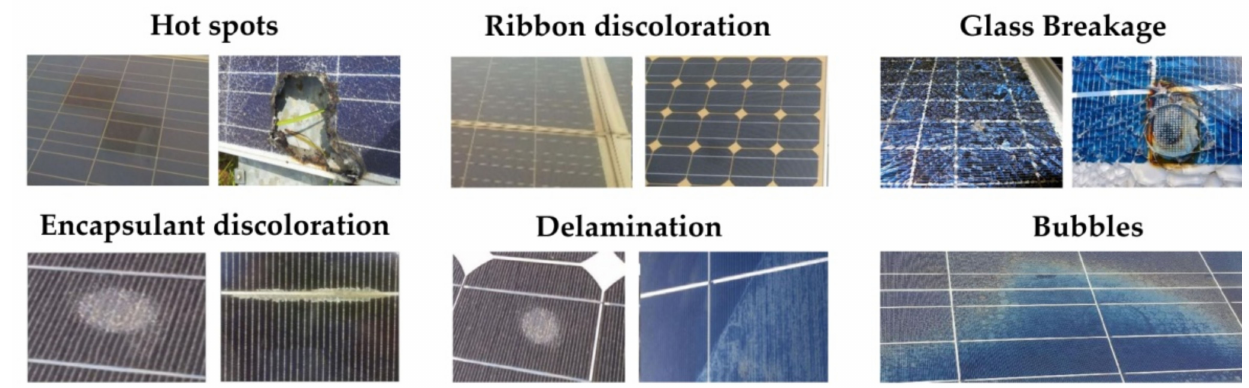
Figure 3. Illustration of common degradation types in PV modules. Reproduced from [4], MDPI: 2021.